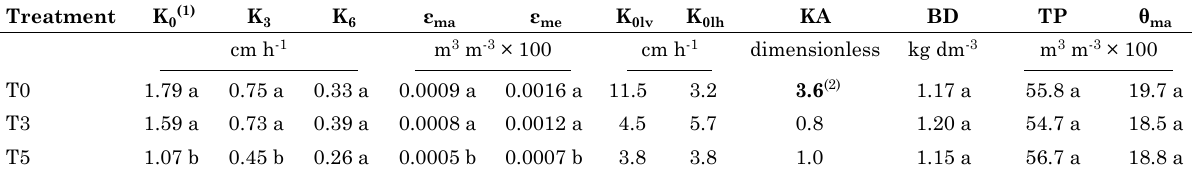
Table 1. Values of field hydraulic conductivity at 0, 3, and 6 cm water tension (K 0 , K 3 , and K 6 , respectively); water-conducting macro- and mesoporosity (ε ma and ε me ); vertical and horizontal laboratory saturated hydraulic conductivity (K 0lv , and K 0lh , respectively); saturated hydraulic conductivity anisotropy factor (KA); bulk density (BD); derived total porosity (TP), and total macroporosity (θ ma ) as a function of traffic treatments (traffic frequency of zero, three, and five tractor passes in the same tracks - T0, T3, and T5,